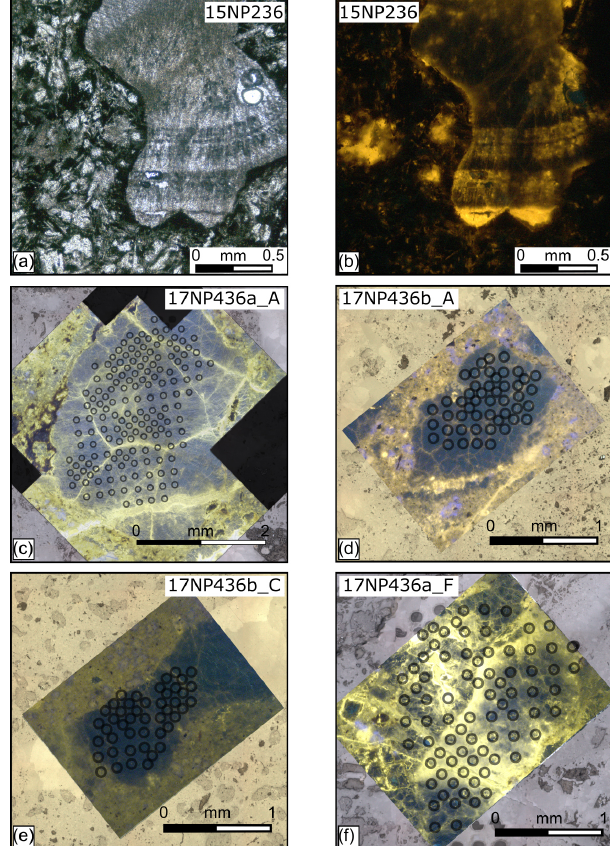
Figure 4. Microphotographs under plain light (a) and cathodo- luminescence (b) of an exemplary vesicle from sample 15NP236 show primary botryoidal structure of the calcite. Primary calcite seems non-luminescent to dull luminescent. Cathodoluminescence images of ablation areas 17NP436a_A (c) , 17NP436b_A (d) , and 17NP436b_C (e) show relatively homogenous non-luminescent calcite cement fragments with a small portion of bright-yellow veins. The calcite cement fragments are embedded in a dull- yellow luminescent volcaniclastic matrix. All three samples yielded high-quality calcite U–Pb ages (MSWD < 2). Ablation area 17NP436a_F (f) , which has a high portion of bright-yellow calcite, yielded a less precise age (MSWD = 3.5). Ablation spots for geo- chemistry and U–Pb dating are marked with grey